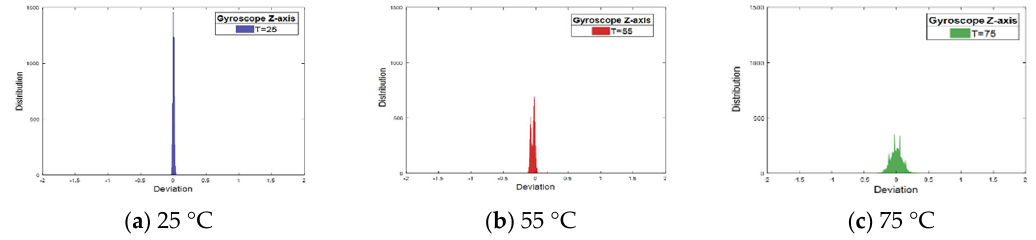
Figure 14. Noise distribution chart of the Z ‐ axis of the gyroscope sensor.